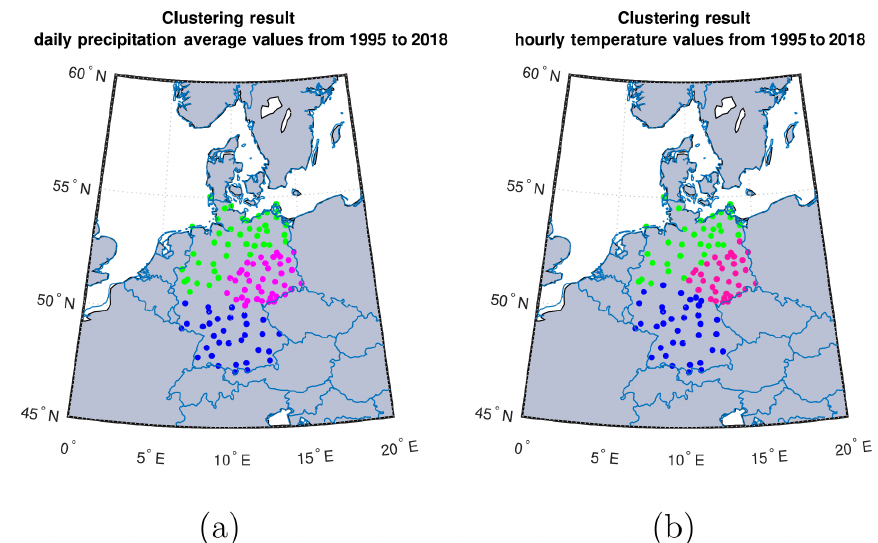
Figure 4. Clustering result for the (a) daily precipitation amounts network taken from the hourly DWD data set with similarity defined by MMI, and (b) the hourly temperature network with similarity defined by NMMI over the time interval from 1995 to 2018.